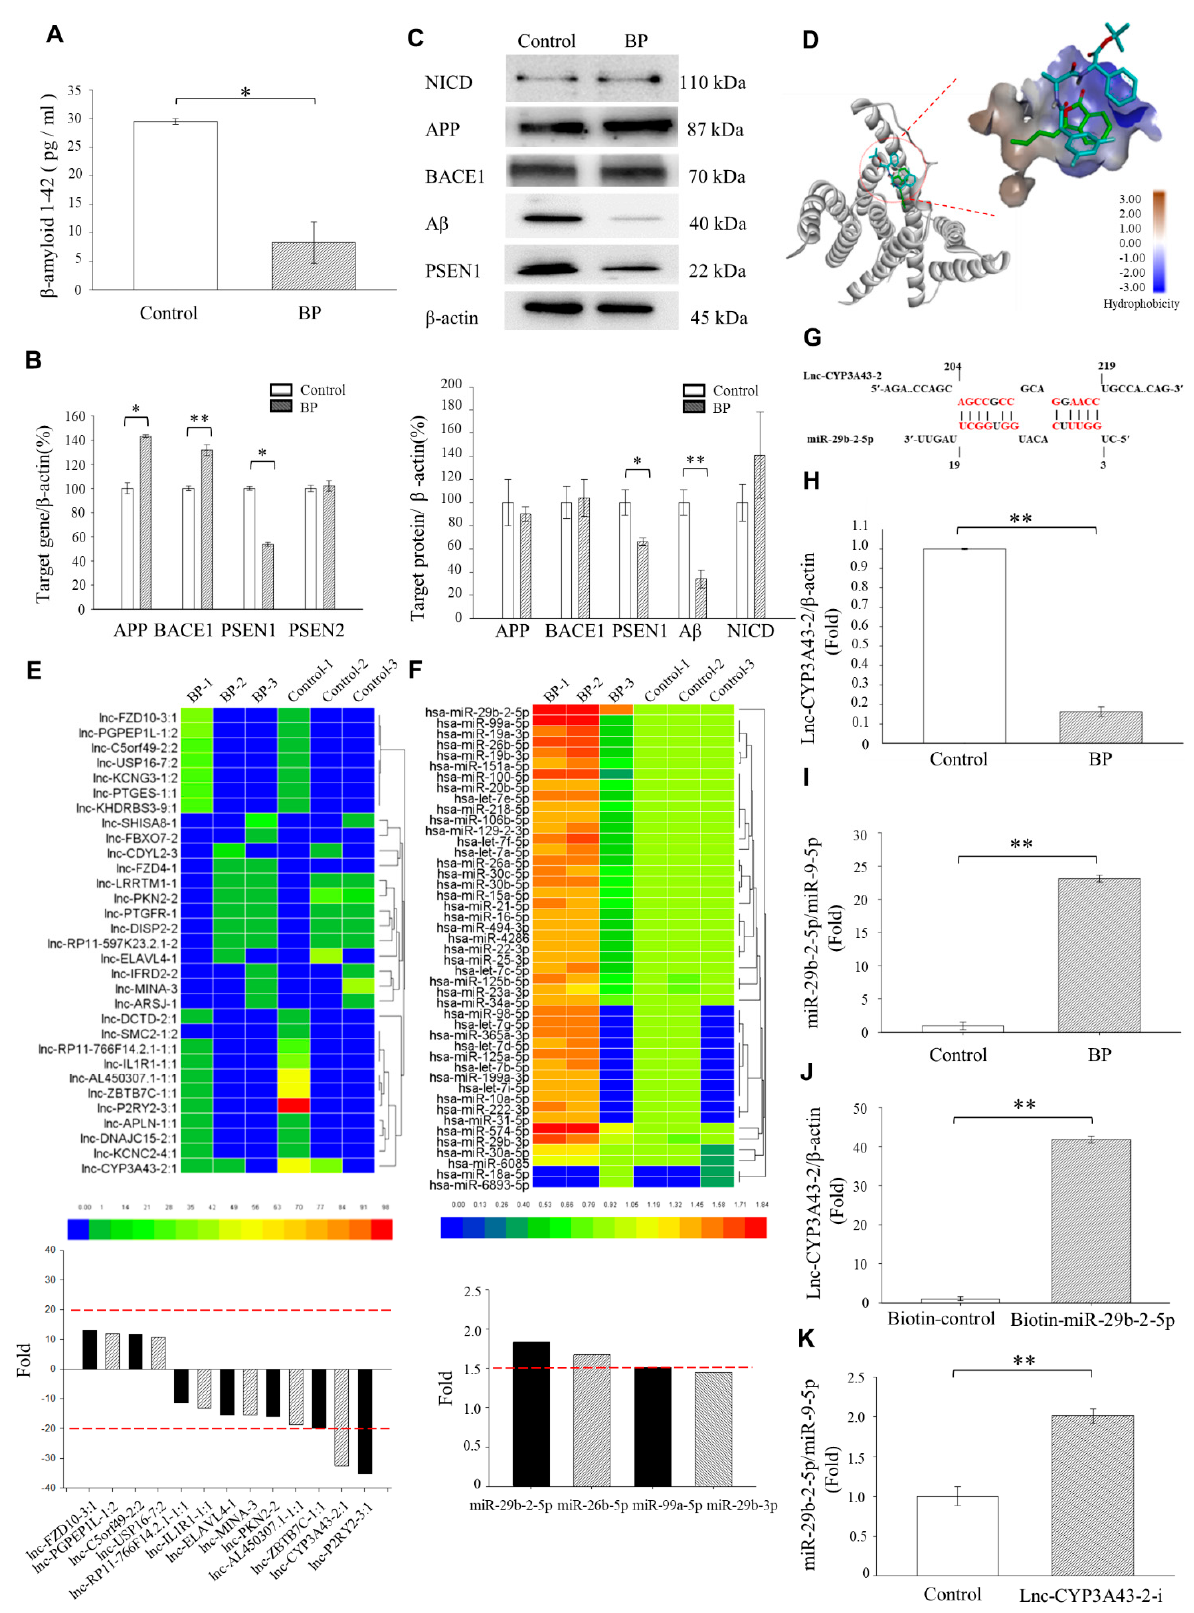
Figure 1. Increased miRNA-29b-2-5p expression and decreased PSEN1 and A β expressions in BP-treated Ts21-iPSC-derived neurons. ( A ) Quantification of A β 42 levels in the medium of control and BP-treated cells evaluated using ELISA (Control = 29.44 pg/mL ± 1.05, BP = 8.28 pg/ml ± 7.31), n = 3